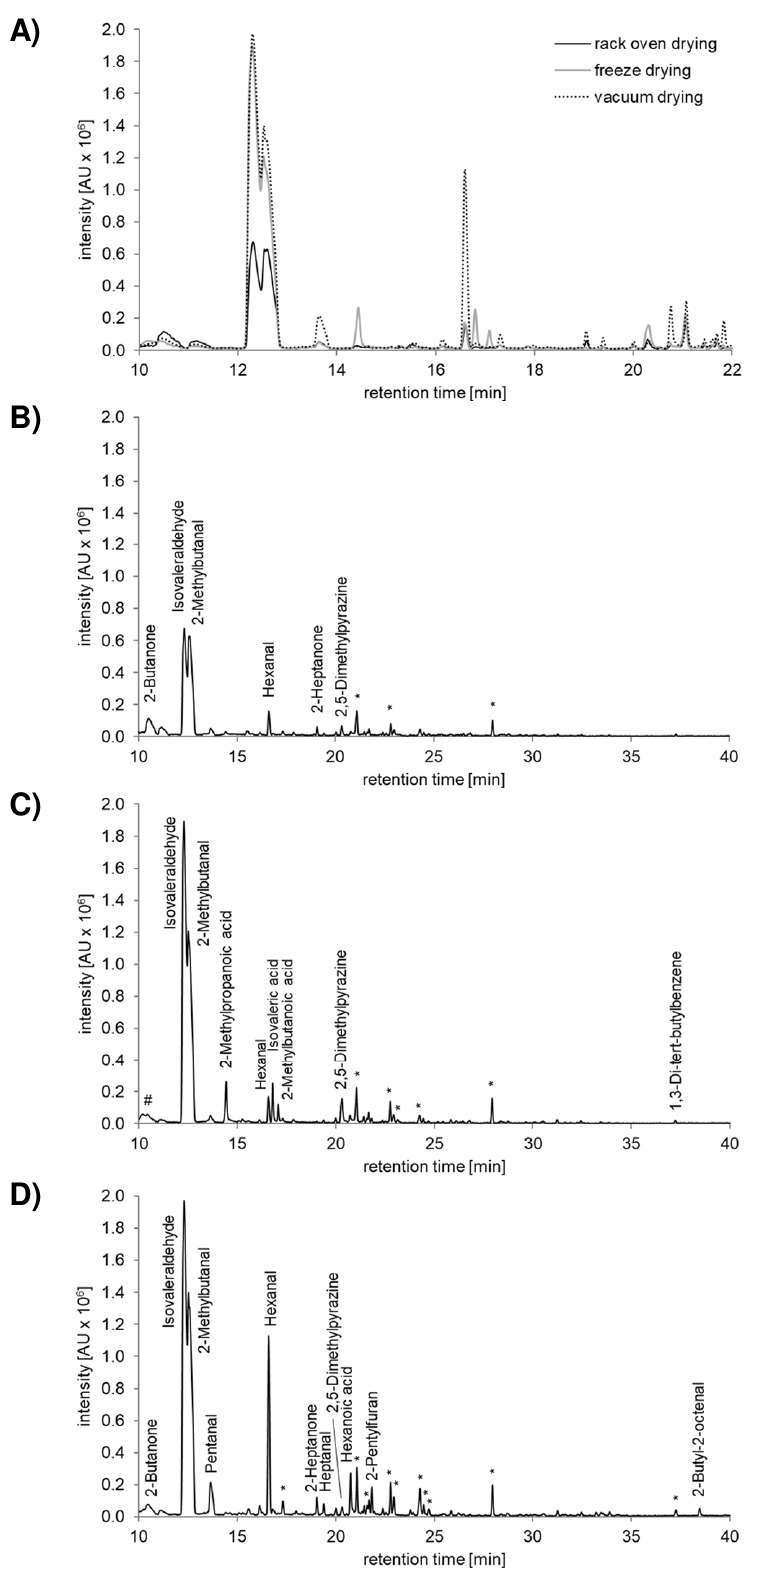
Figure 1. Headspace gas chromatographicanalysis of dried Tenebrio molitor larvae. Representative GC-chromatograms out of three independent head space GC − MS experiments are shown in overview ( A ) and in detail for rack oven drying ( B ), freeze drying ( C ) and vacuum drying ( D ). * alkanes < 0.002% w/w, # mixed peak of 2-butanon and